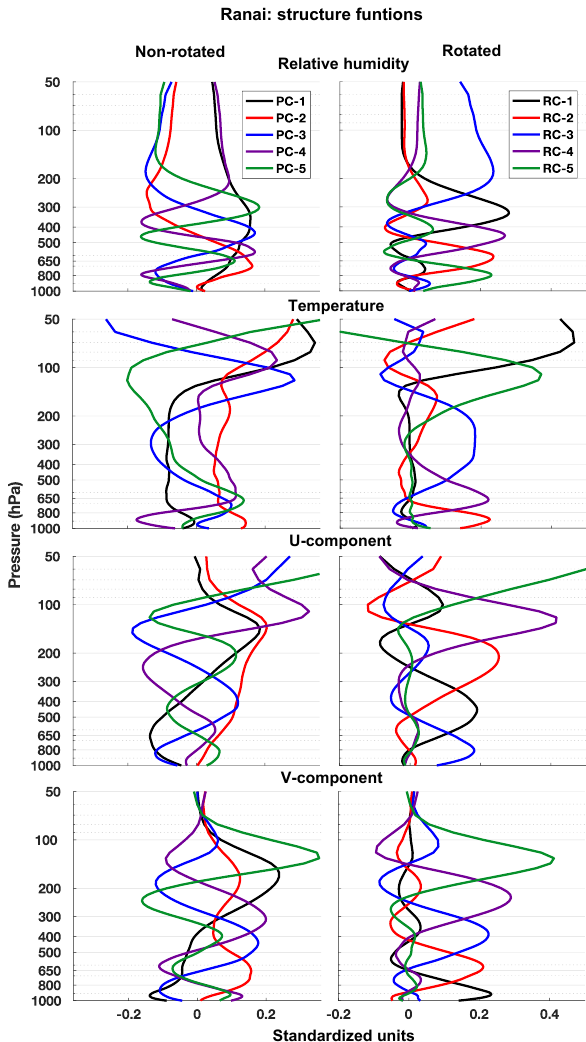
Figure 6. Non-rotated PCs (left panels) and rotated components (right panels) for all variables at the Ranai upper-air sounding site. Only one sign of the eigenvector is plotted. The strong modality (sign change) is apparent in the PCs, whereas the RCs have five modes total due to the Varimax rotation, but only one mode con- tains a strong